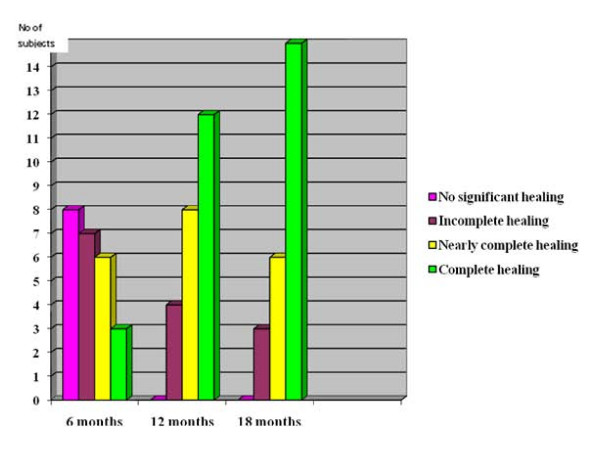
MRI Score Progress.